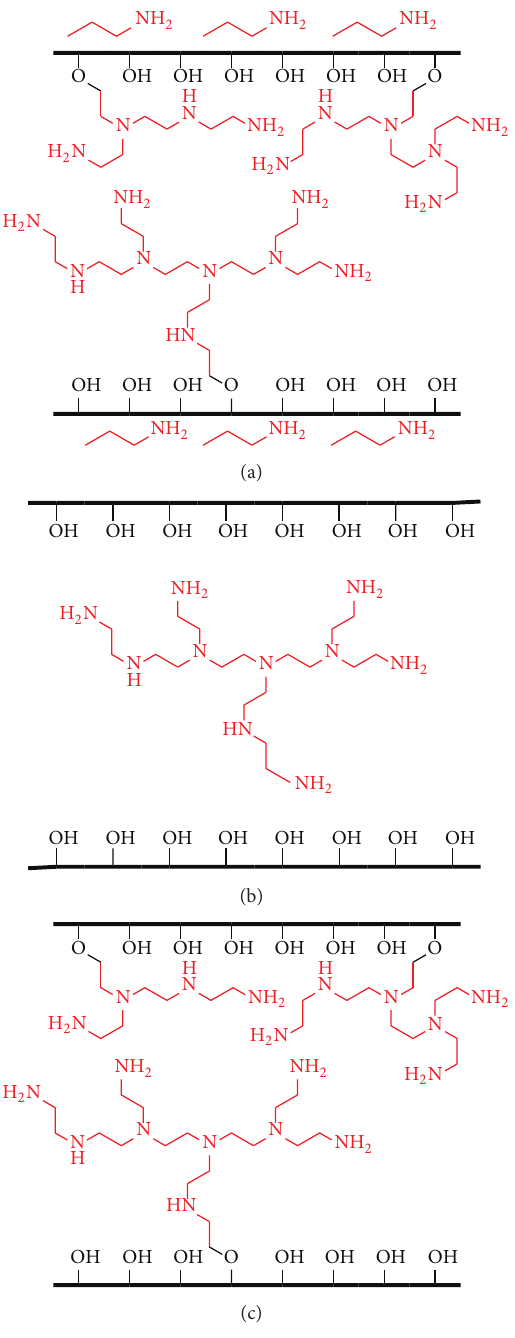
Figure 5: Porous silica pores loaded with polyethylenimine (PEI) using three different loading techniques: (a) cocondensation, (b) impregnation, and (c) postsynthesis